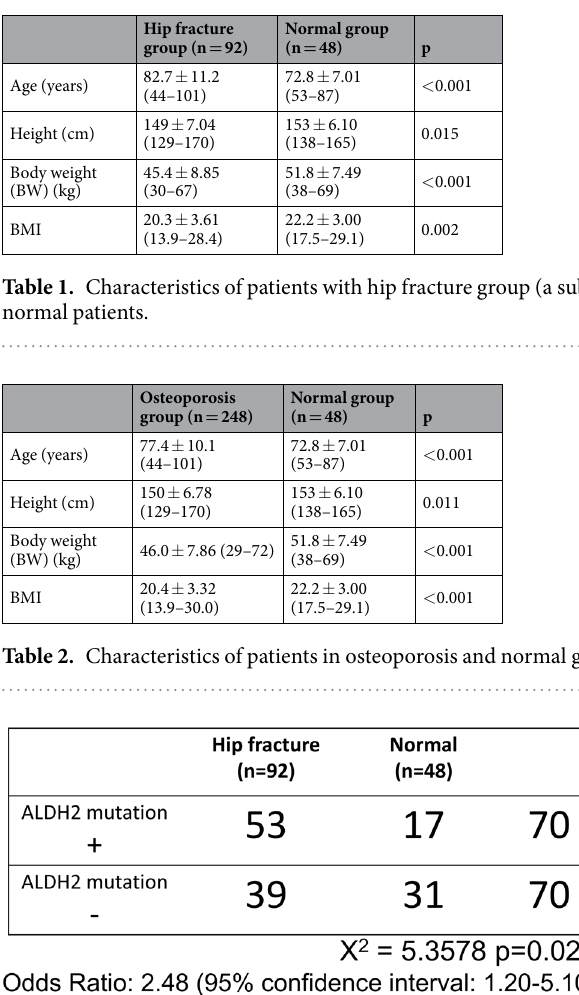
Figure 2. ALDH2 rs671 mutation in hip fracture and normal groups. The presence of rs671 in research subjects was analyzed by direct sequencing. Subjects heterozygous or homozygous for the mutation are designated ( + ) and subjects with the wild-type ALDH2 gene are designated ( − ). Odds ratios and 95% confidence intervals for rs671 in the hip fracture group were determined, and a Chi-square test was